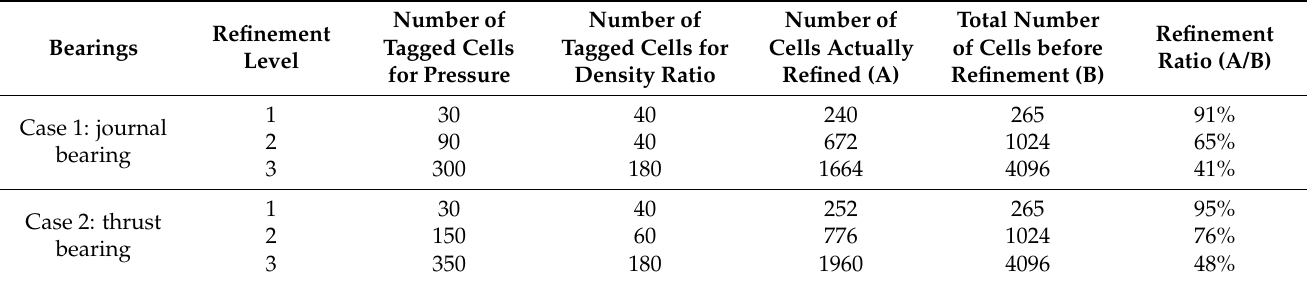
Table 3. Refinement strategy for the two cases.